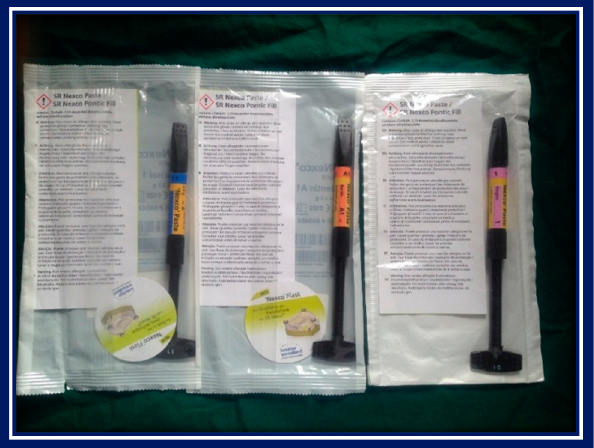
Figure 1. SR Nexco paste layering materials—incisal, dentin, and gingiva.